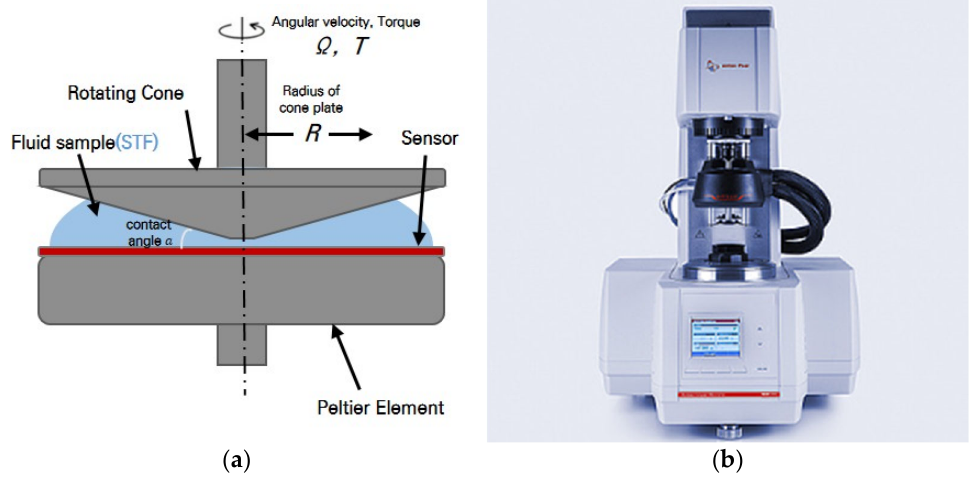
Figure 2. ( a ) Rheometer schematic and ( b ) Anton ‐ Paar MCR301 rheometer.